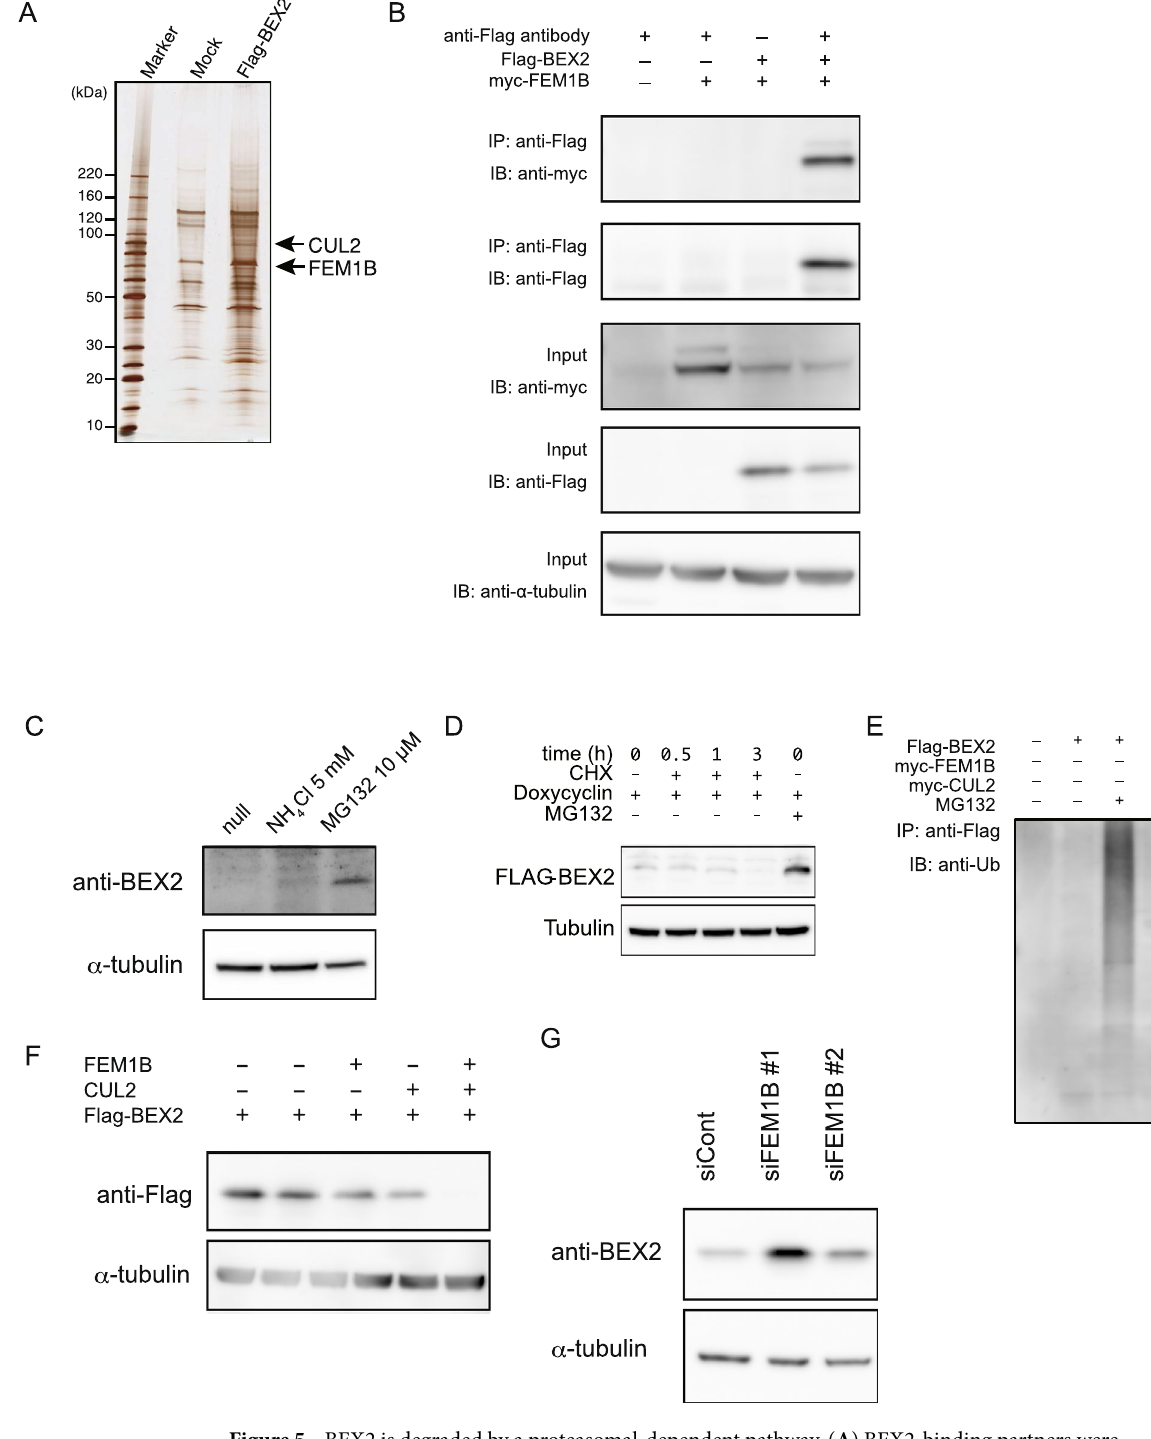
Figure 5. BEX2 is degraded by a proteasomal-dependent pathway. ( A ) BEX2-binding partners were determined by LC/MS analysis. Immunoprecipitation (IP) was performed using 293 T-FlpIn-T-REx-Flag- BEX2 cells. ( B ) Immunoprecipitation of FEM1B using anti-Flag antibody. Flag-BEX2 and myc-FEM1B were transfected into 293 T cells, and IP was performed. ( C ) HuCCT1 cells were stimulated with the lysosomal inhibitor (NH 4 Cl) or proteasomal inhibitor (MG132) and the expression level of BEX2 was determined by western blot analysis. ( D ) The degradation rate of Flag-BEX2 in 293 T-FlpIn-T-REx-Flag-BEX2 cells was determined by western blot analysis. CHX, cycloheximide. ( E ) Immunoprecipitation assay of 293 T cells transfected with the indicated plasmids and immunoprecipitated with an anti-Flag antibody showed that Flag- BEX2 was ubiquitinated under the co-transfection of FEM1B and CUL2. ( F ) 293 T cells were transfected with the indicated plasmids and the expression level of Flag-BEX2 was determined by western blot analysis. ( G ) FEM1B expression was knocked-down by targeted siRNA in HuCCT1-BEX2 cells. Two days after transfection, cells were harvested and BEX2 expression was determined by western